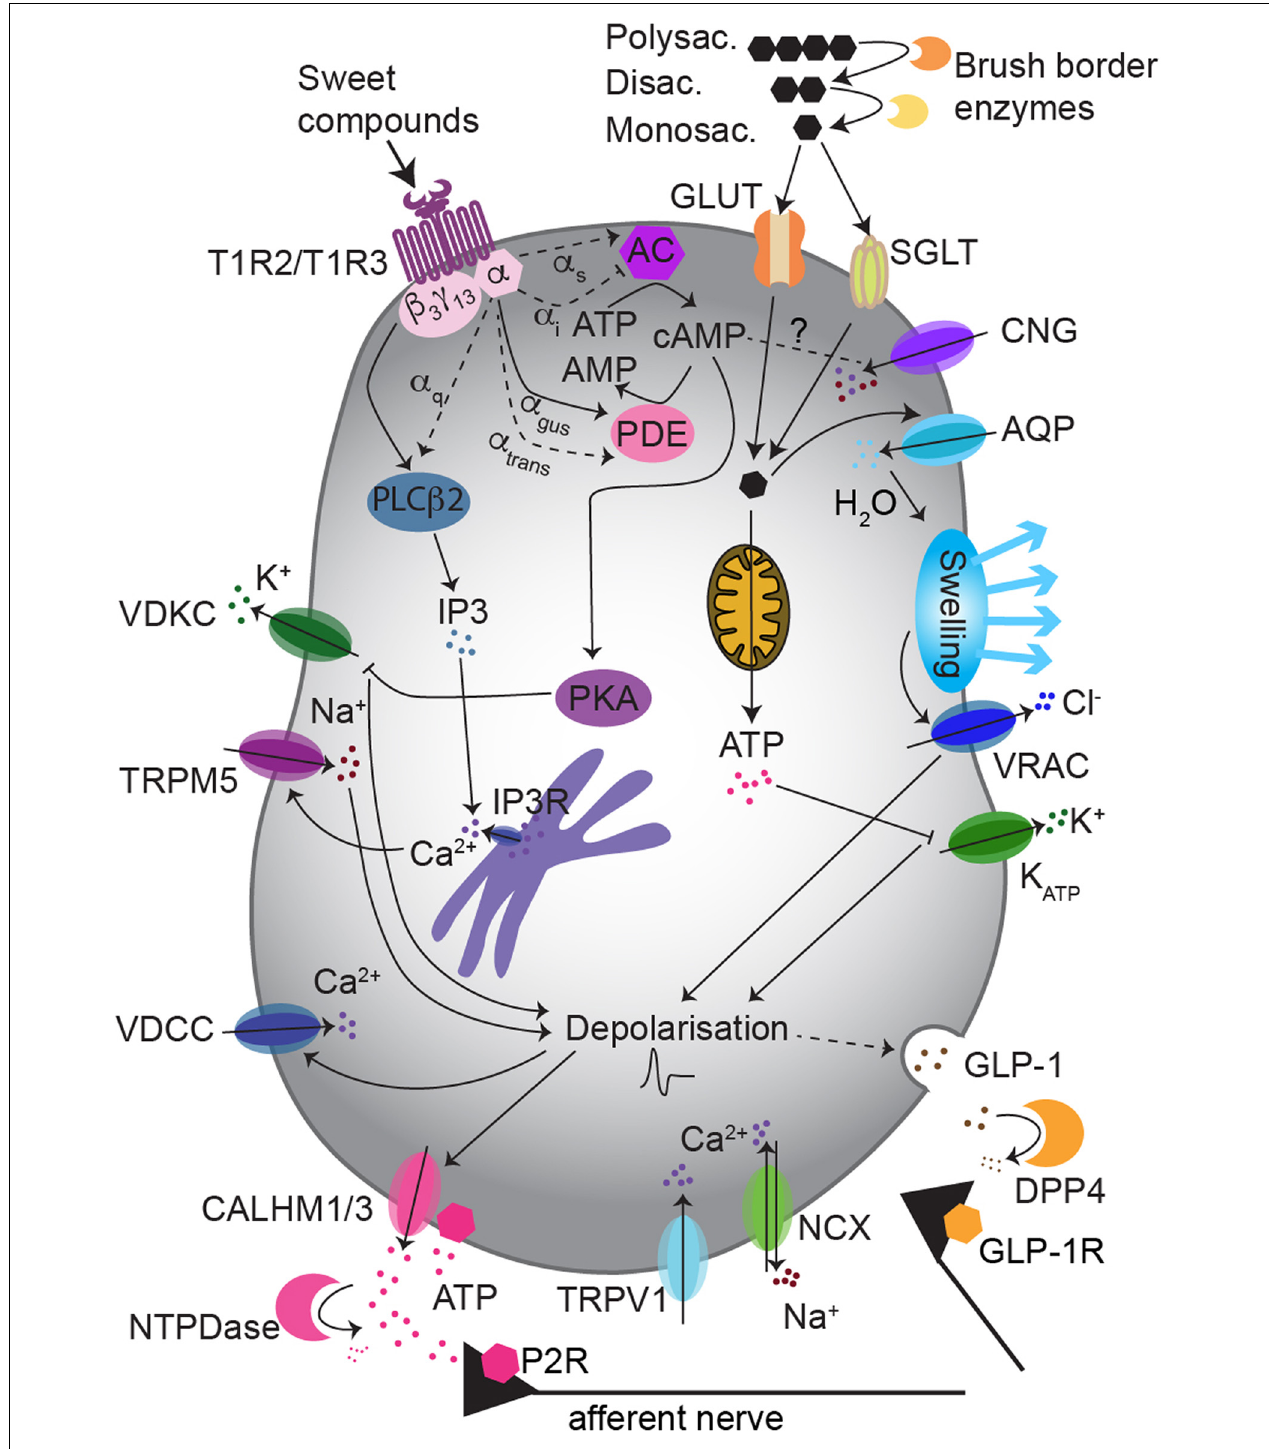
FIGURE 1 | Sweet taste transduction uses multiple pathways in type II taste bud cells. The “canonical pathway” implies the activation of gustducin by T1R3/T1R2 receptor, which then promotes: intracellular Ca 2 + rise via PLC β 2/IP3 signaling, cell depolarization via TRPM5 and ATP release. Non-caloric sweeteners may preferentially use the PLC β 2/IP3 pathway, while sugars may rather activate a cAMP/PKA pathway, depolarizing the cell via K + channels inhibition. The “alternative pathway” possibly involves glucose influx via GLUTs and/or SGLT1, increase of ATP and inhibition of K ATP -mediated K + outflow. This may induce GLP-1 release. Abbreviations: AQP, aquaporins; DPP4, dipeptidyl peptidase 4; CALHM1/3, Ca 2 + homeostasis modulator 1/3; VDKC, voltage-dependent K + channel; P2R, purinergic receptor class 2; GLP-1R, GLP-1 receptor.